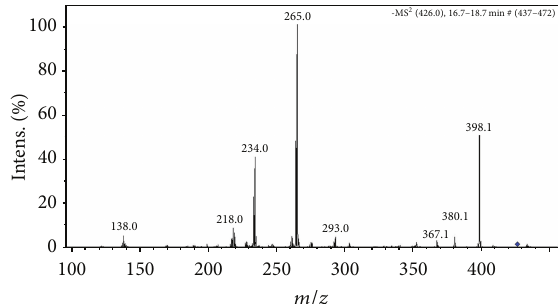
Figure 5: MS 2 spectrum of the molecular ion m/z